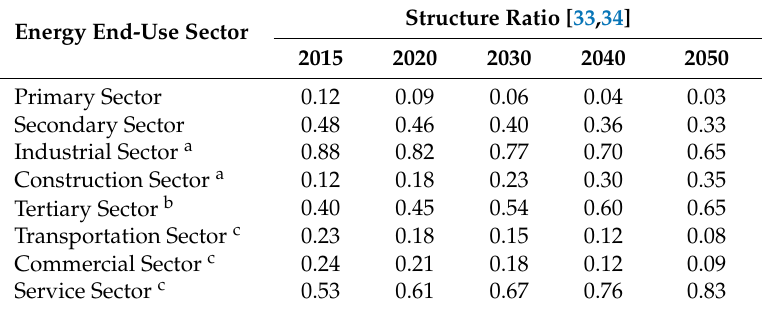
Table 1. The designed proportion of the industry structure in the ISO in the